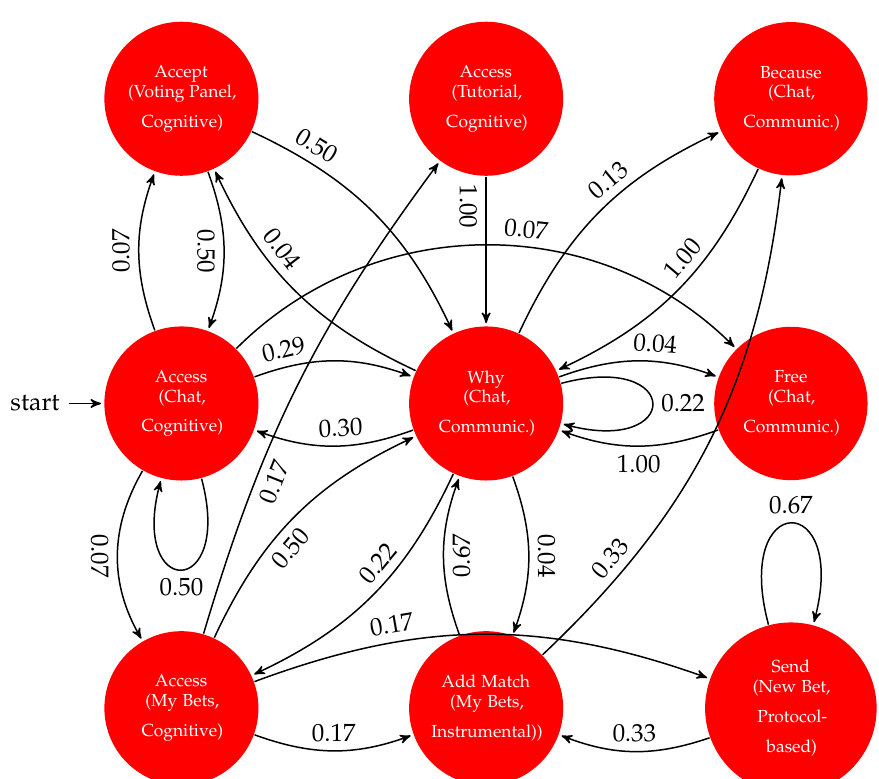
Figure 6. Analysis of interaction data sequences of a user. The nodes represent the actions performed by the user and the links the probability that an action will be next. The predicted value for that user regarding the Execution Speed is